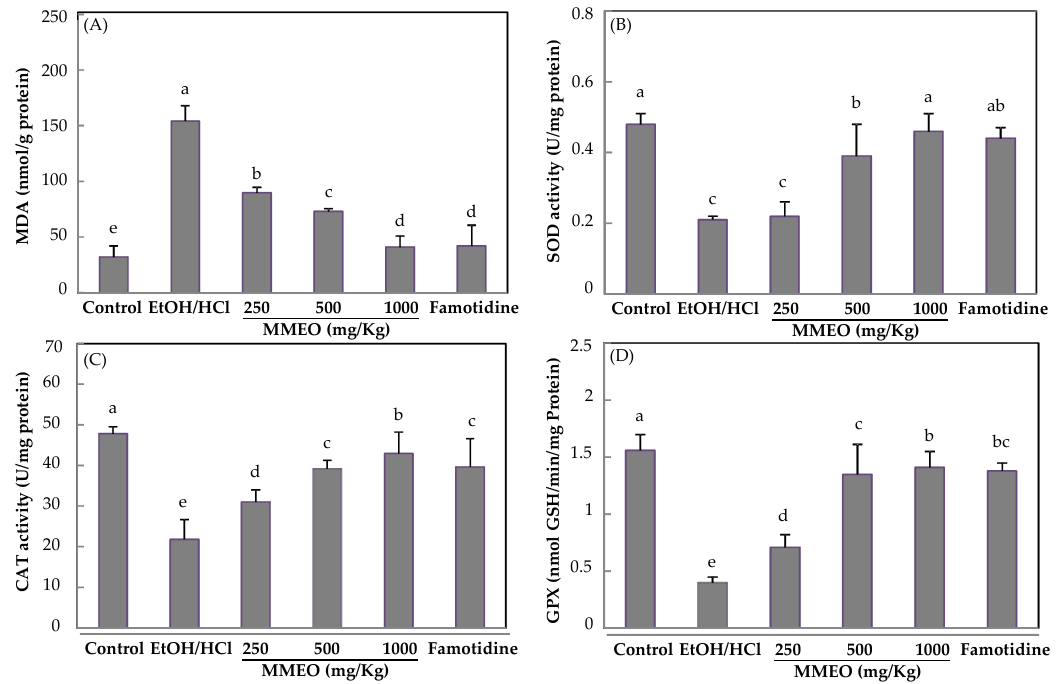
Figure 6. Effect of oral pre-treatment with microencapsulated M. communis essential oil (MMEO, 250, 500 and 1000 mg/Kg) on MDA concentration ( A ), and superoxide dismutase (SOD) ( B ), catalase (CAT) ( C ) and glutathione peroxidase (GP X ) ( D ) activities. Values are the means ± SD of three independent assays. Values with different superscripts (a–e) are significantly different at p < 0.05 as compared to control group.